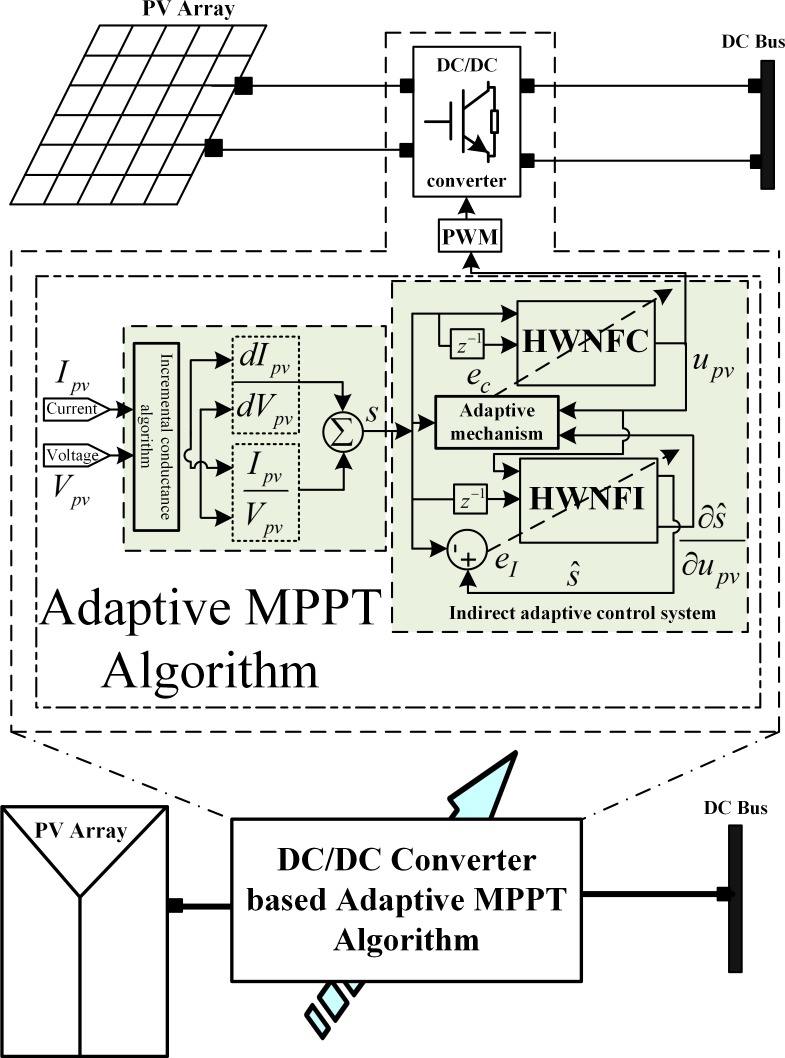
PV subsystem model.